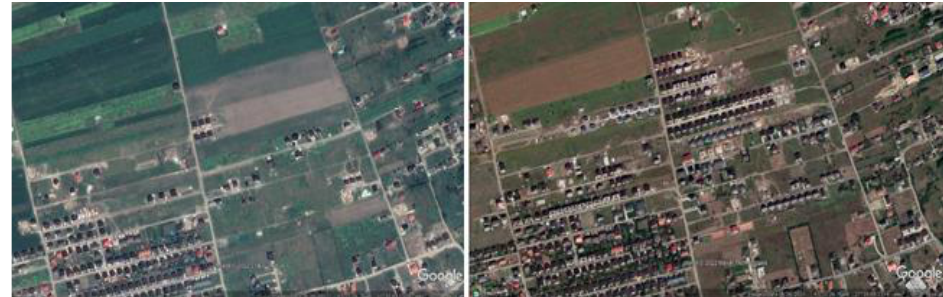
Remote Sens. 2022 , 14 , 6011